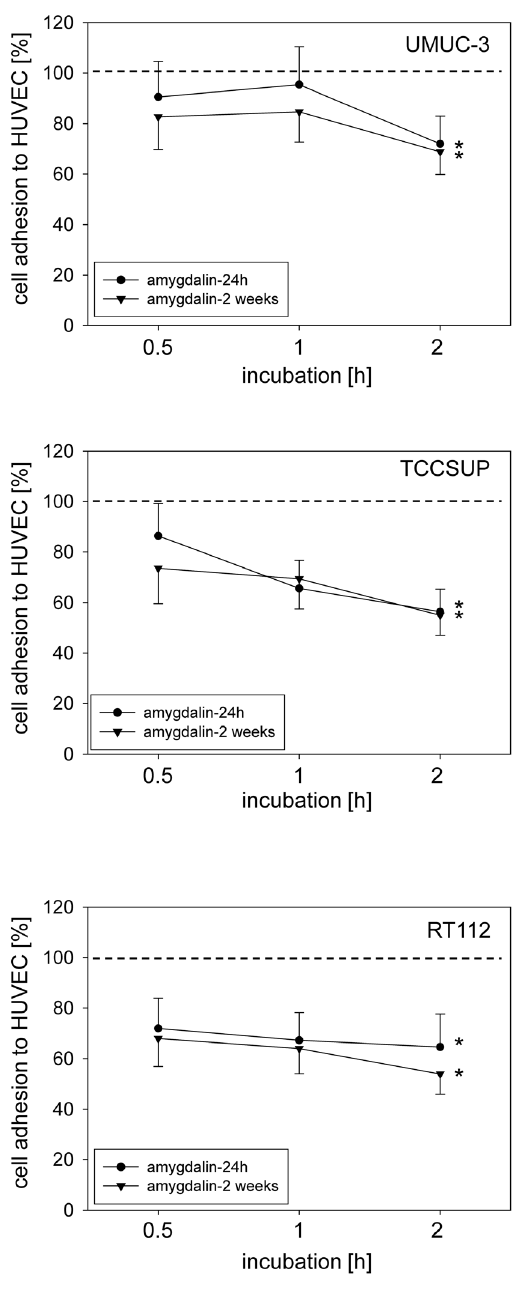
Figure 1. Adhesion of UMUC-3, TCCSUP and RT112 bladder cancer cells to HUVEC. Tumor cells were treated with 10 mg/ml amygdalin for either 24 h or for 2 weeks. Controls received cell culture medium alone. 0.5 6 10 6 tumor cells/well were added to HUVEC monolayers for 0.5, 1 and 2 h. Mean adherent tumor cells from five fields was calculated and depicted as percentage of the 100% control (dotted line). One representative of six experiments is shown. *indicates significant difference to